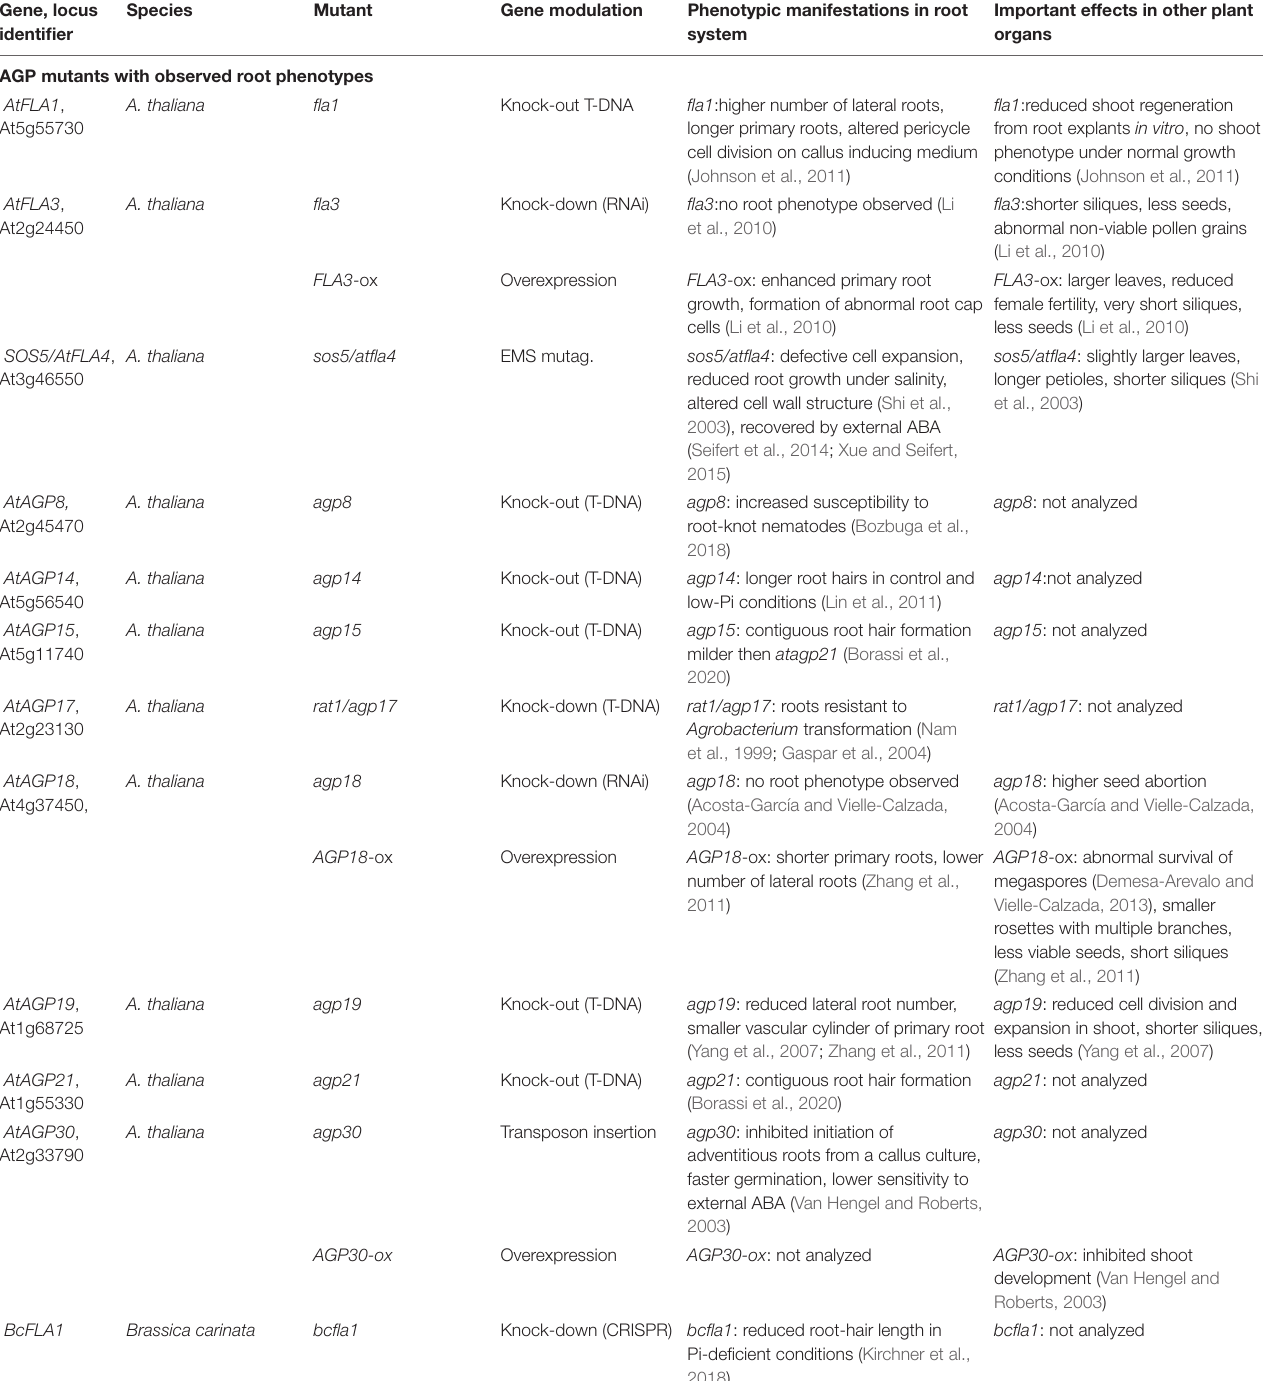
Important effects in other plant system organs